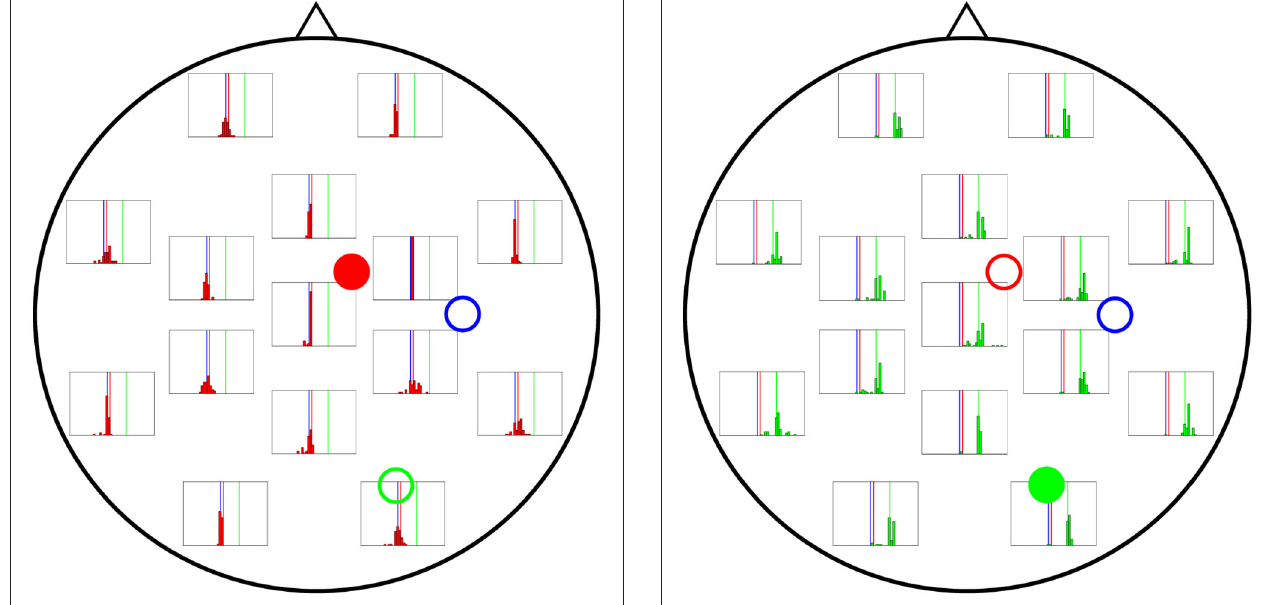
FIGURE 6 | Distribution of 50 realisations of A estimations from a single electrode for cortical column 1 (solid red circle). The histograms are placed at the location of the corresponding measuring electrode, and the location of the three cortical columns generating the activity are shown with coloured circles (with the full circle corresponding to the column whose value of A is being estimated in this figure). Vertical lines with the same colours as the circles mark the corresponding actual A values. The distributions tend to be narrowest in the vicinities of cortical column 1. Nevertheless, they do not group around the target value of A 1 4.25 mV (vertical red line), as they should, but around that = of A 3 3.25 mV (vertical blue line). =